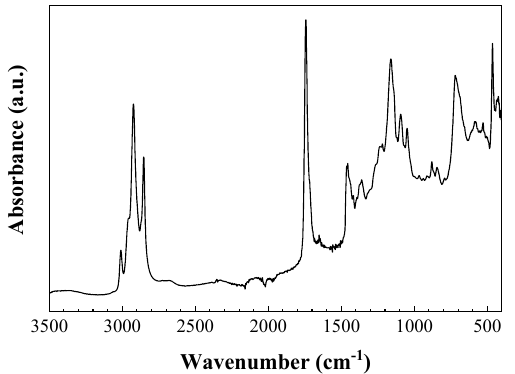
Figure 2. Attenuated total reflection (ATR)-Fourier-transform infrared spectroscopy (FTIR) spectra of Mo 15 S 19 nanoparticles dispersion in linseed oil.